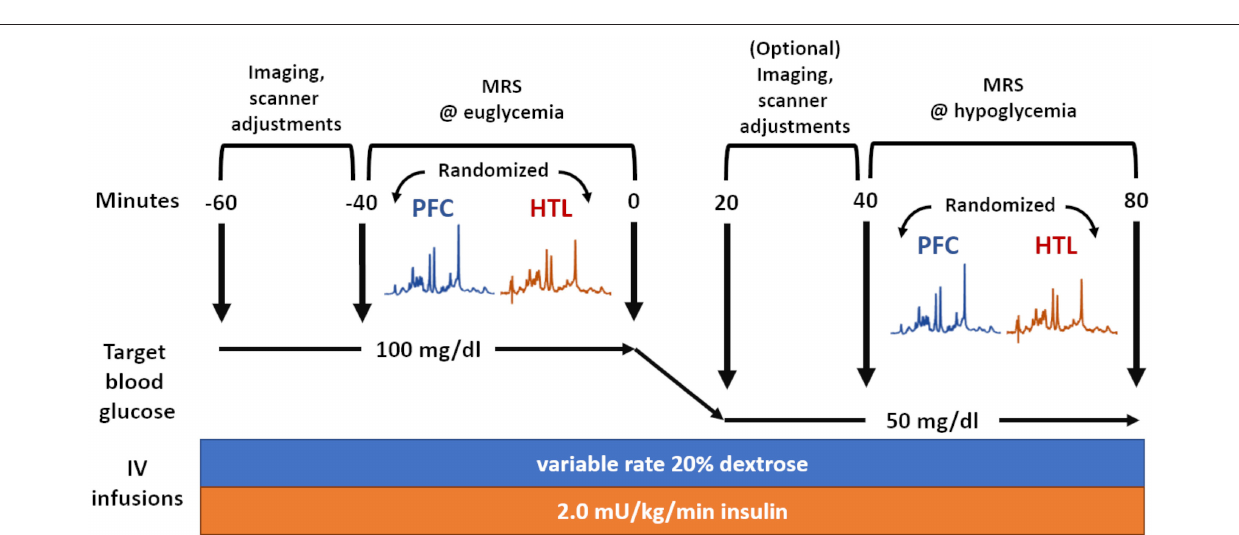
VOI from prior work (40) were multiplied by 1.5. Metabolites with between-subject mean Cramér–Rao lower bounds (CRLB) equal to or < 20% were reported. Sum of metabolites were